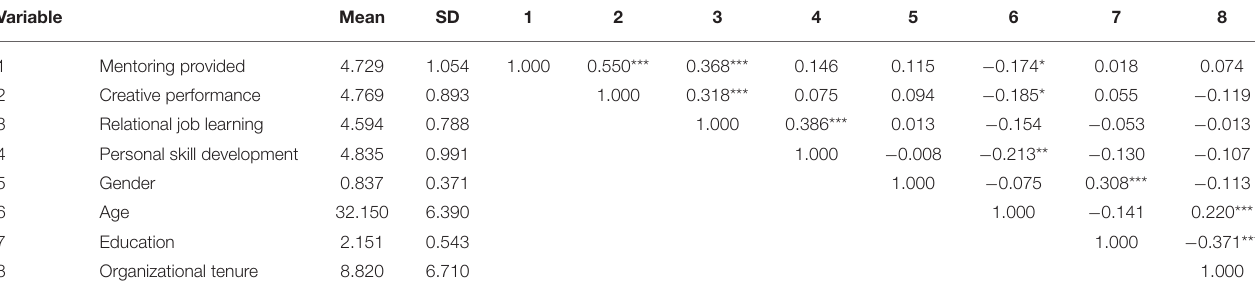
TABLE 1 | Means, SDs, and correlations. Variable